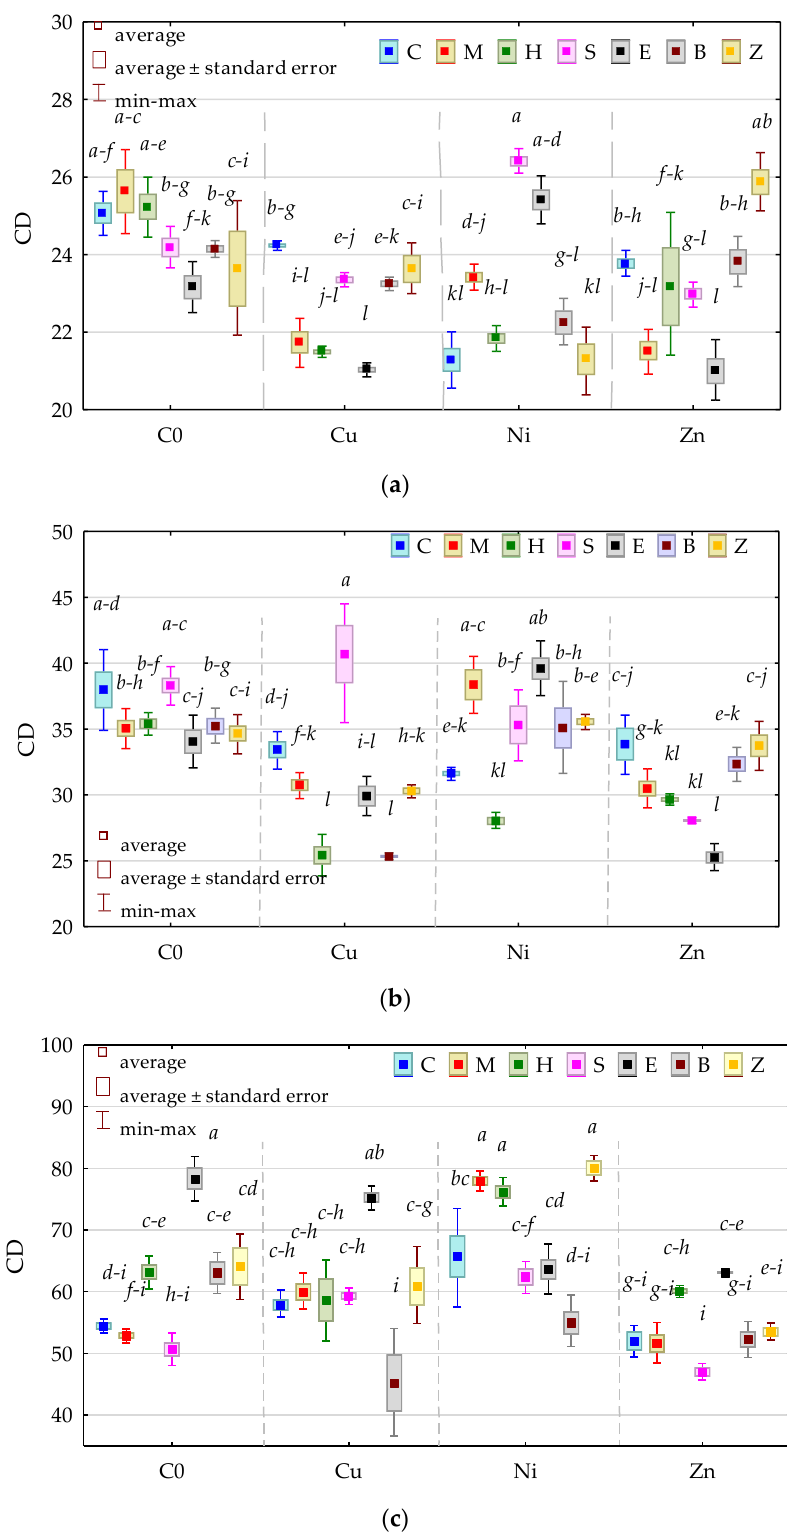
Figure 2. The colony development index (CD) ( a ) organotrophic bacteria, ( b ) actinomycetes, and ( c ) fungi. C—control; M—molecular sieve; H—halloysite; S—sepiolite; E—expanded clay; B—biochar; Z—zeolite; C0—uncontaminated soil; Cu—ion Cu 2+ ; Ni—ion Ni 2+ ; Zn—ion Zn 2+ . Homogeneous groups were calculated for CD values determined for all sorbents (denoted with letters